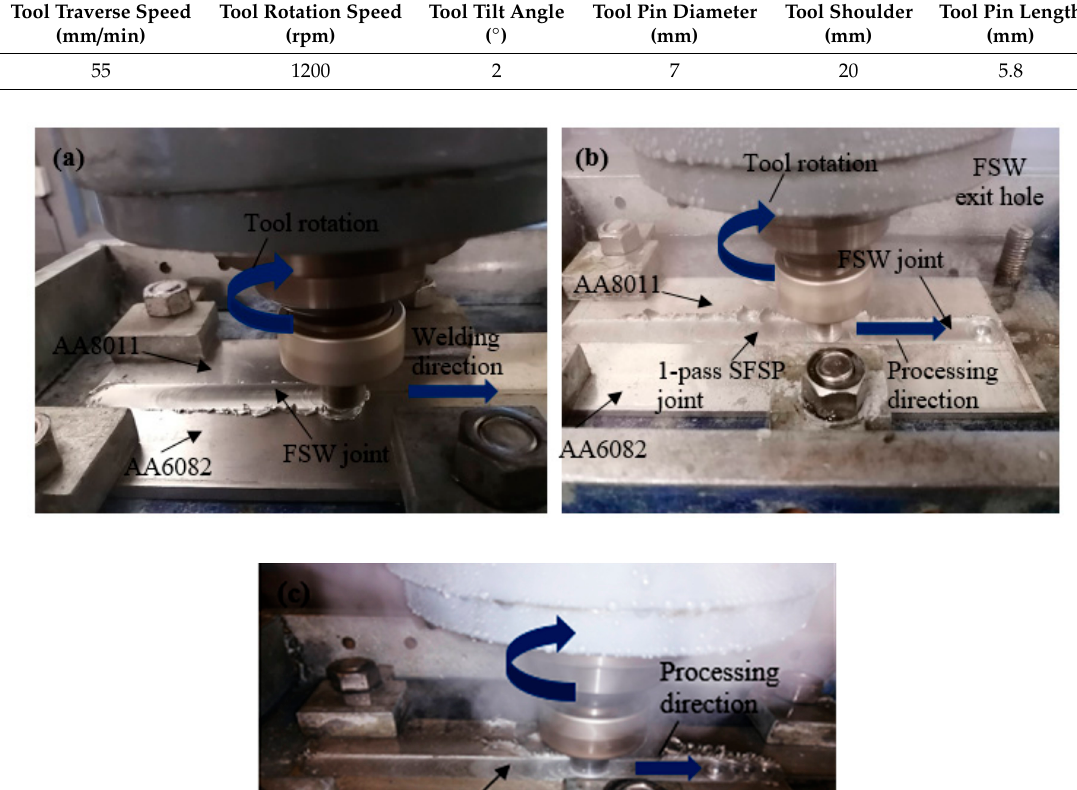
Table 1. Chemical compositions [28,29].